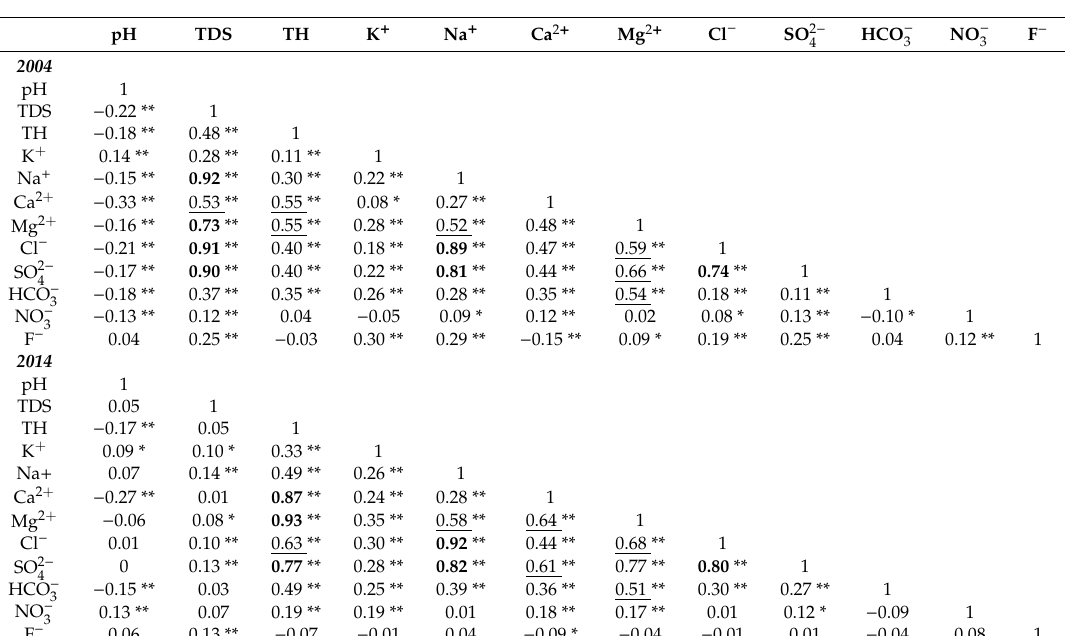
Figure 2. Piper plots illustrating the groundwater chemistry/water type for samples in ( a ) 2004 and ( b ) 2014. Table 2. Pearson correlation coe ffi cient matrix of 12 physico-chemical variables of groundwater samples for 2004 and